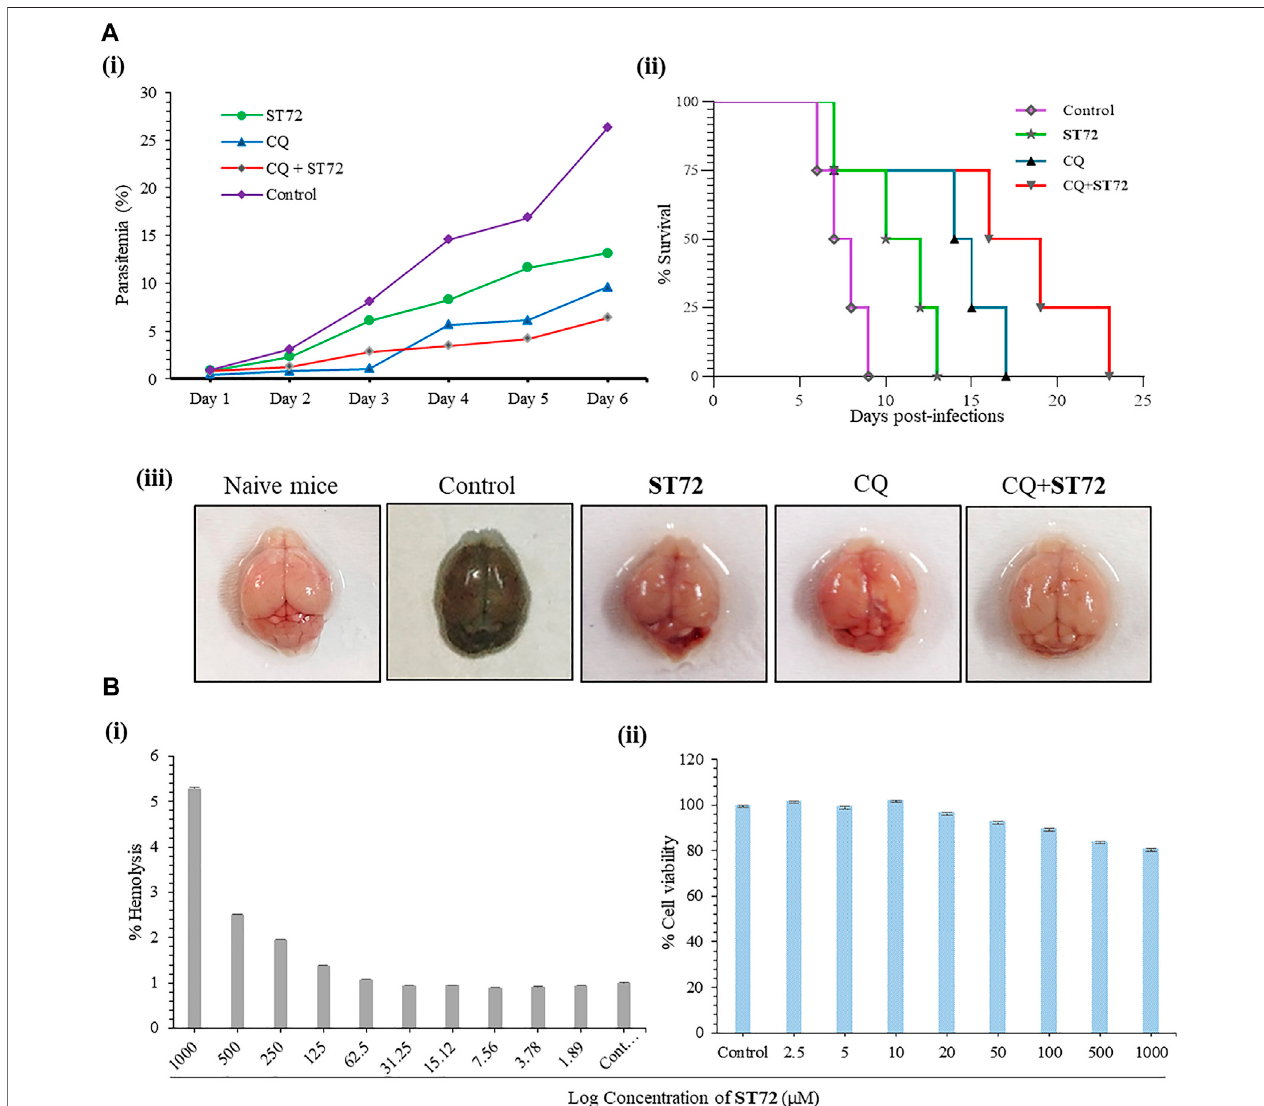
FIGURE 5 | (A) In vivo antimalarial activity of ST72 was evaluated against P. berghei ANKA in Balb/c mice. ST72 (2.5 mg/kg body weight; n = 4), chloroquine (6 mg/kg body weight; n = 4), and combination (2.5+6 mg/kg body weight; n = 4) were administered intraperitoneally in P. berghei ANKA – infected Balb/c mice for six consecutivedays.Theuntreatedgroupofmicewastakenascontrol.Thinbloodsmearsweremadeuptoday6post-infection.(A(i))Graphshowingpercentreductionin parasitemia in ST72-treated mice or in combination with CQ. (A (ii)) The survival of mice was observed up to 24 days post-infection. The graph showed better survival in ST72-treated mice as compared to control percentage survival of mice. (A (iii)) Evans blue staining of brains of P. berghei – infected mice 7 days post-infection. (B (i) ) A graph showing the effect of ST72 in a dose-dependent manner on human RBCs as analyzed by the hemolytic assay. No signi fi cant effect was observed in the treatedsamplesupto500 µM concentration ofST72.(B(ii))ThecolorimetricMTTassaywasusedtoobservethecytotoxicityofST72against humanliverhepatocellular carcinoma (HepG2) cells at 2 – 1,000 µM concentrations. The graph showed percent cell viability of HepG2, and the experiment was performed in triplicate. Data were shown as mean values ±